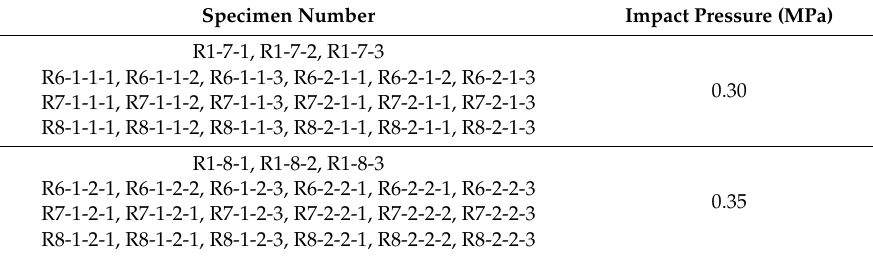
Figure 5. The split Hopkinson pressure bar (SHPB) test system. Table 2. Split Hopkinson pressure bar (SHPB) test